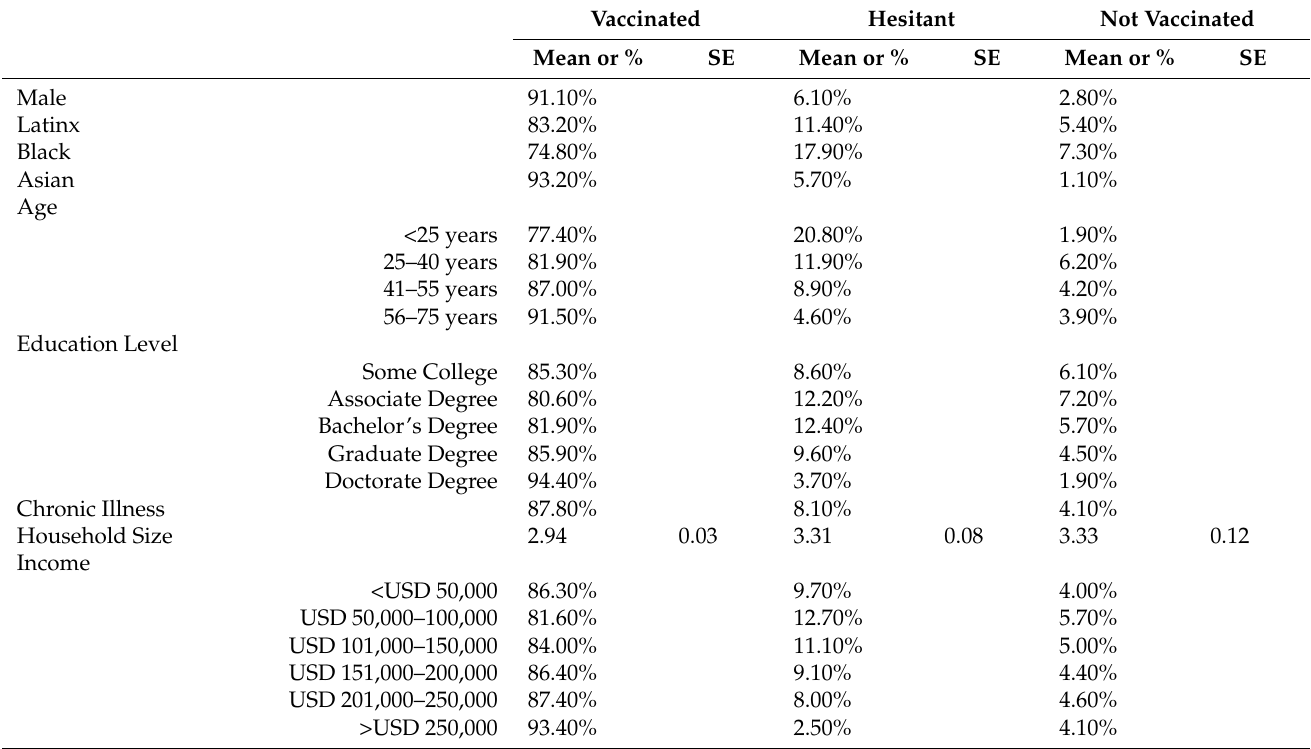
Table 3. Univariate distribution of data across three outcome